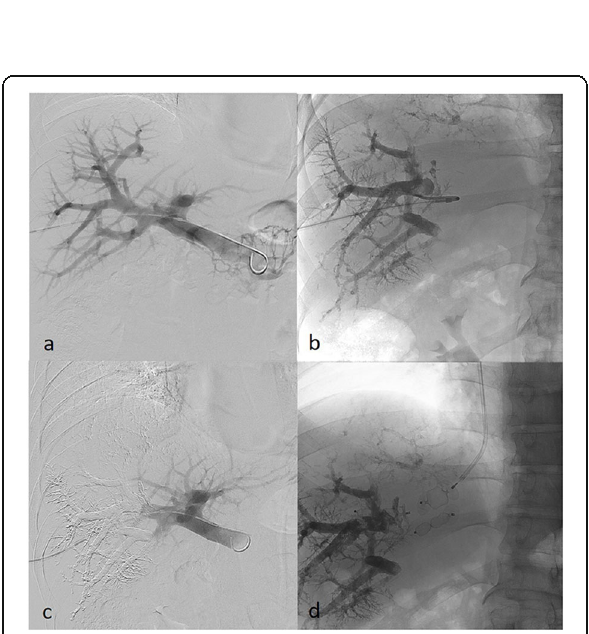
Fig. 2 a-d Combined embolization of the portal vein and then right hepatic vein. a portal venogram before embolization. b embolization of the right portal branches with Glubran 2 and Lipiodol with casting of fifth order branches. c portal venogram after embolization. d transjugular hepatic plug insertion using 12 mm and 14 mm diameter Amplatzer type II plugs